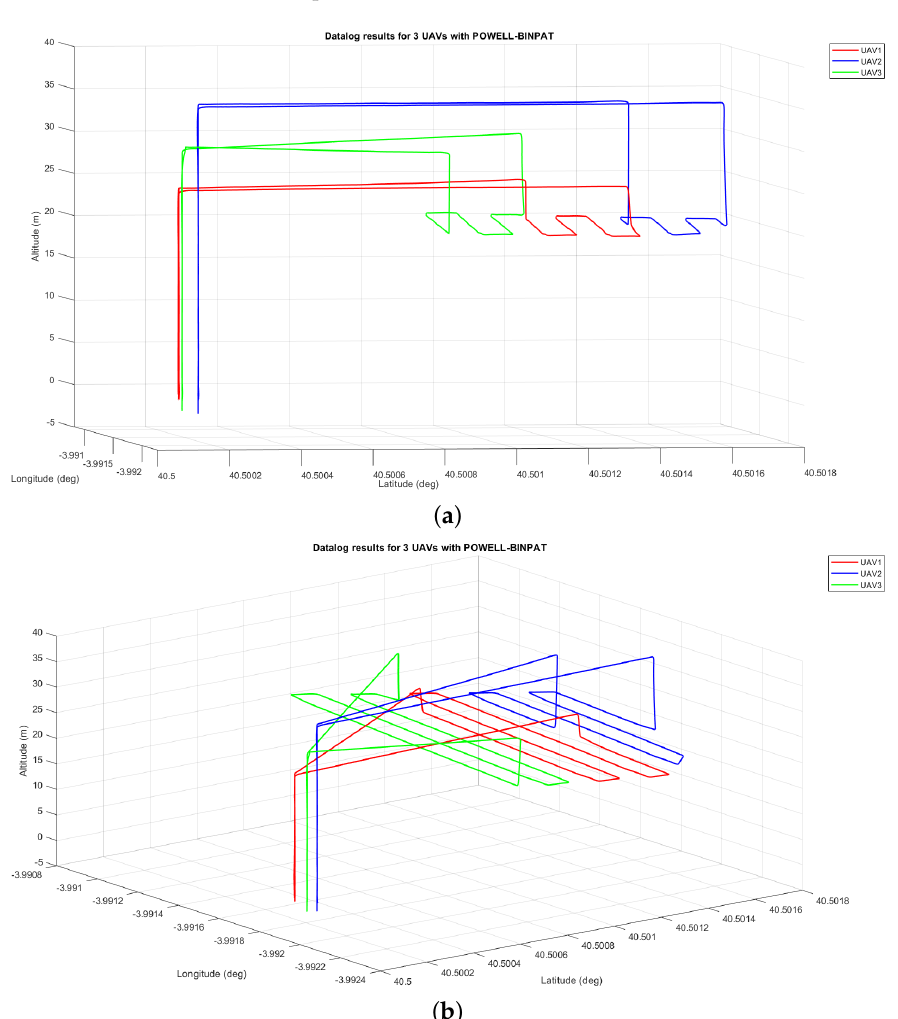
Figure 15. UAV positions reported by datalog in 3 UAV flights using POWELL-BINPAT: ( a ) main view; and ( b ) side view